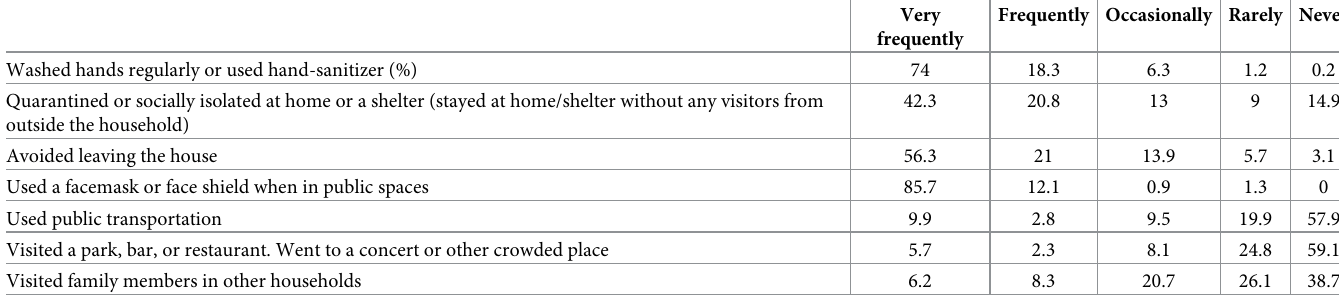
Table 3. Self-reported COVID-19 prevention measures and risks in the past six months.